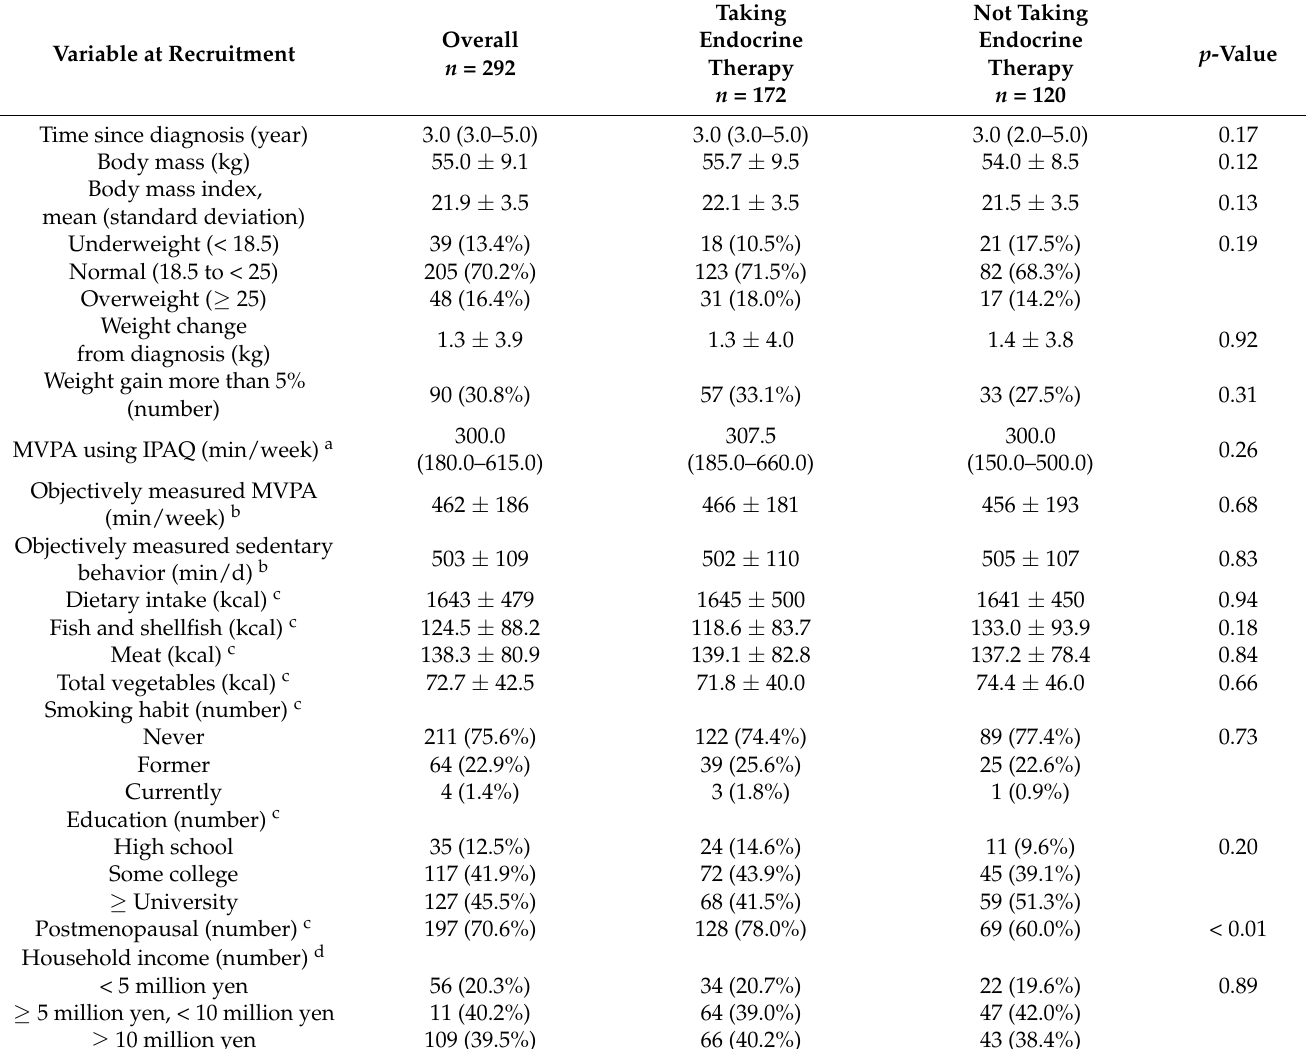
Table 2. Patient characteristics at